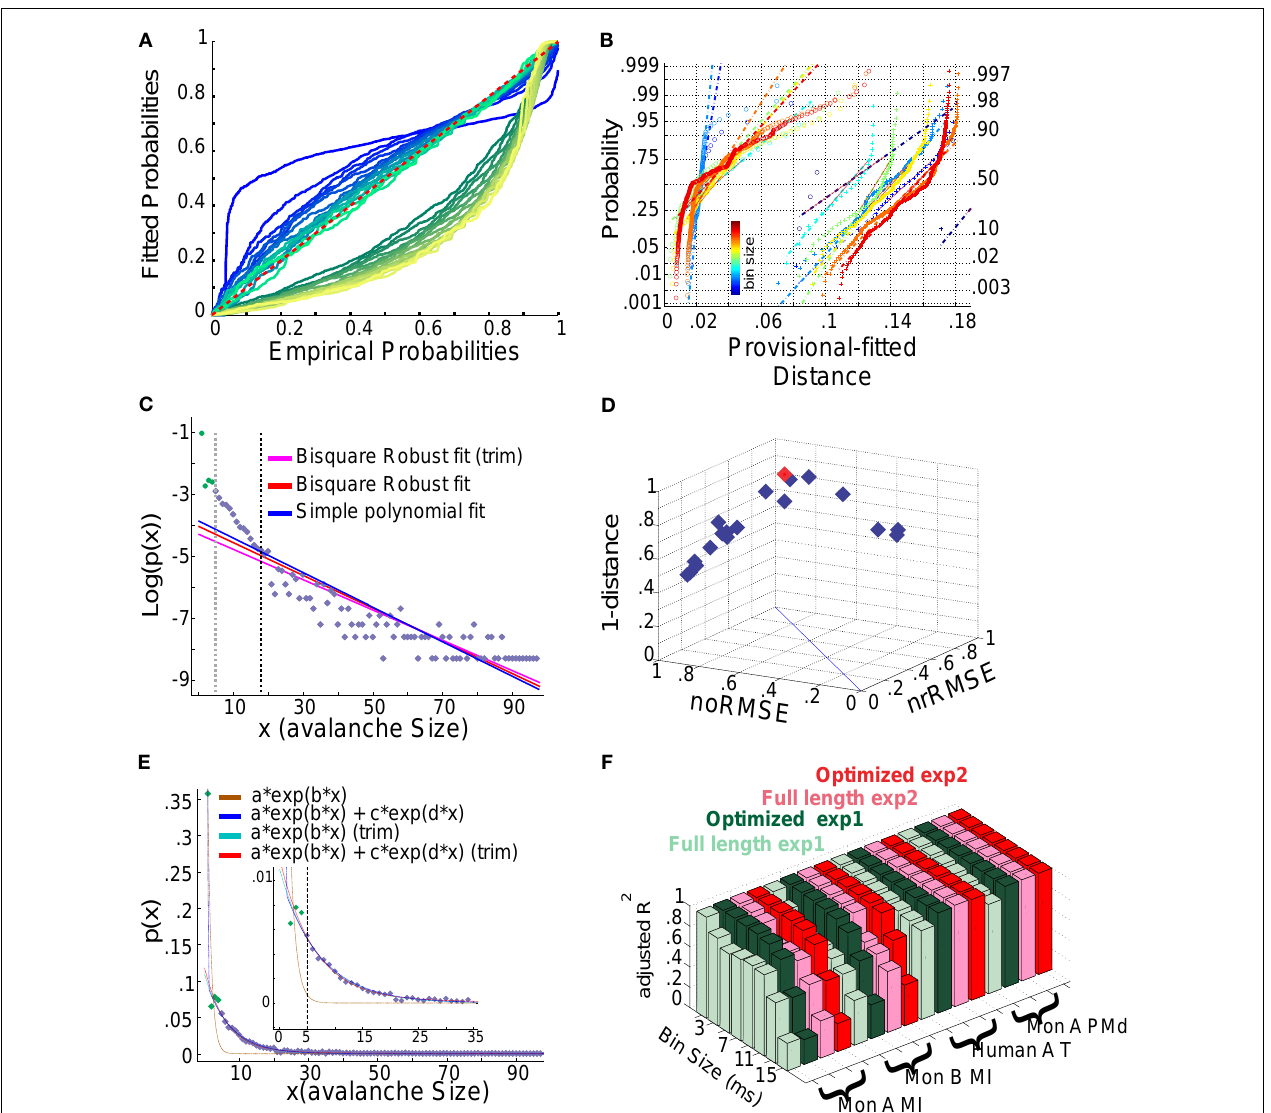
fits to different reductions of the same dataset.The 3 coordinates are “normalized overall improvement of RMSE” (noRMSE), “normalized relative improvement of RMSE” (nrRMSE) and distance of a point from the diagonal in (noRMSE,nrRMSE) plane. Each point in this 3D space, is the result of a bi-square robust fit after elimination of the first i elements of the data (best fit in red). (E) Bi-exponential fitting of the same data.The “sum of exponential” model (exp2) gave a very good performance in both full length (dark blue) and reduced above “ X min ” (red).The “simple exponential” model (exp1) reaches a very good fit only for the reduced set (cyan) but not for the full length of the avalanches (light brown). (F) Effects of linearity improvement on exponential fits. Each set of four colors refer to the spike avalanche of Monkey i (MI), Monkey ii (MI), Human A(Temporal), and Monkey i (PMd). In each set, green colors refer to the simple exponential family (exp1) and the red colors depict the sum of exponentials (exp2). Light green and light red, refer to the calculated ¯ R 2 on full length avalanche sizes, while dark green and red show the average ¯ R 2 for the dataset ranging from N − 1 to N − X min where the optimized length X min was 5 [see (C,D) ]. (C–E) Were obtained from 15ms bin avalanches from human i awake